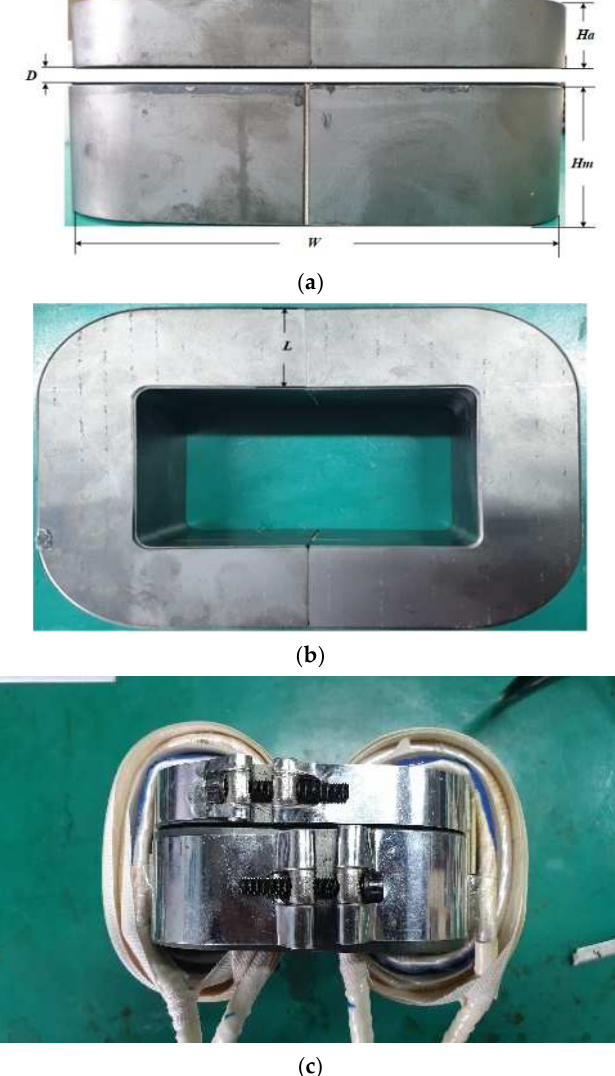
Figure 10. Integral heterogeneous reactor. ( a ): Core side view. ( b ): Core top view. ( c ): Completed heterogeneous reactor.